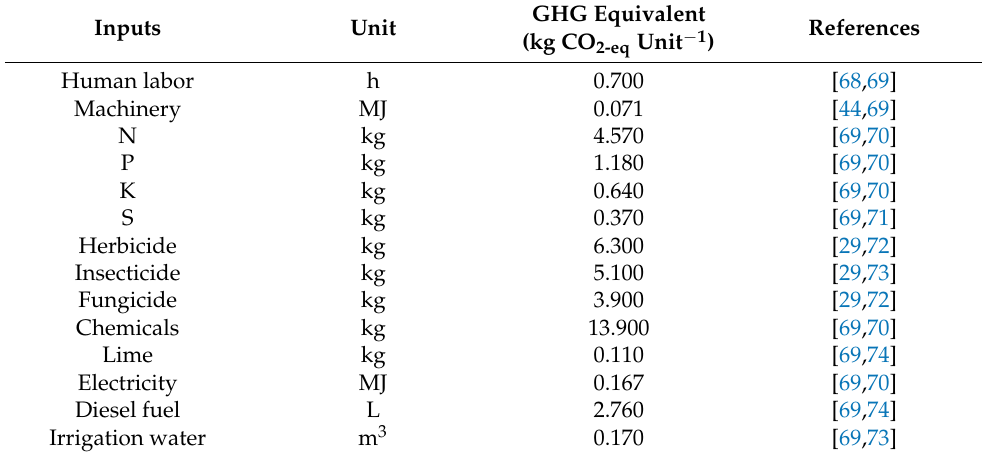
Table 2. Greenhouse gas emissions coefficients in the production of